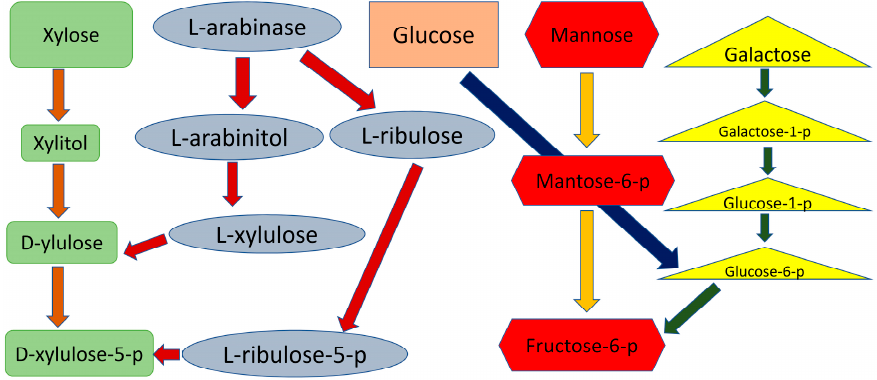
Figure 2. Assimilation pathways for hexoses and pentoses, mannose, glucose and galactose, showing the interconversion of pentoses and pentitols by NAD (PH)-mediated oxidoreductases [11,80].